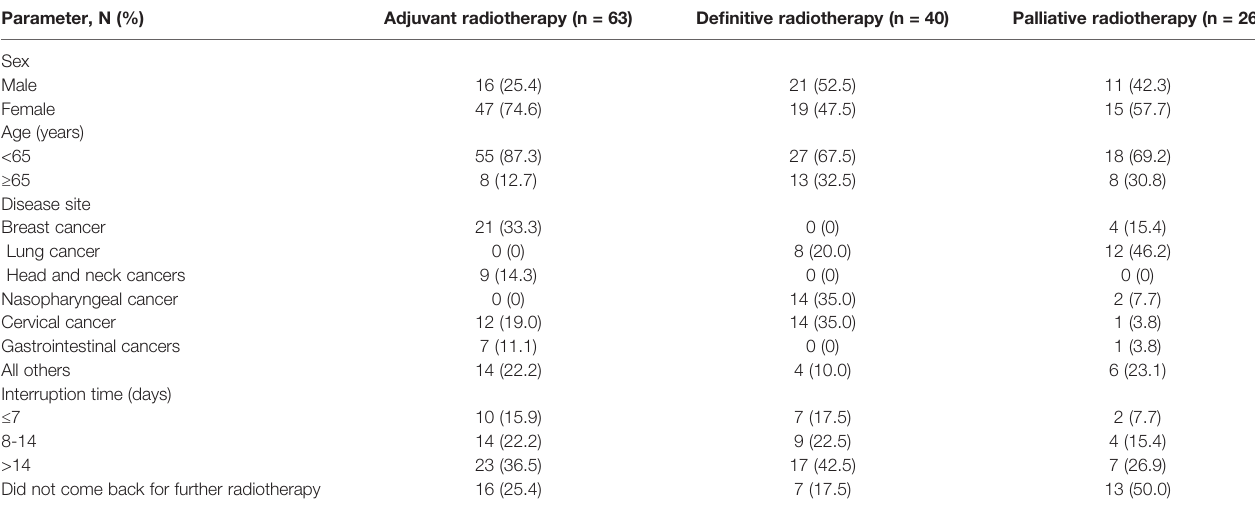
TABLE 1 | Characteristics of patients who underwent interrupted radiotherapy.